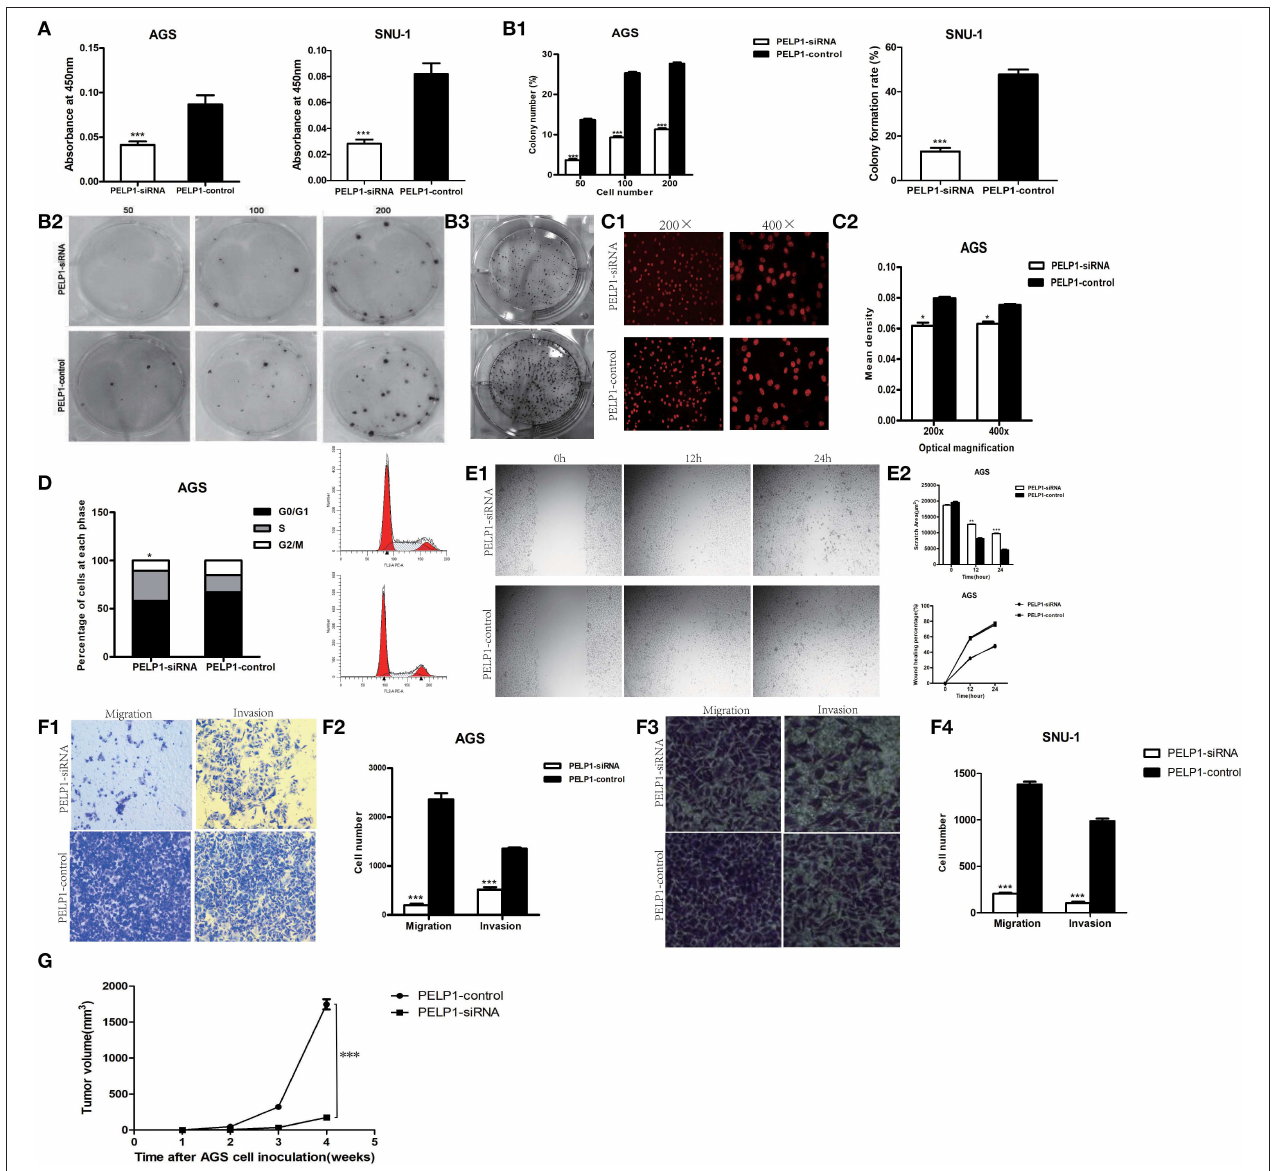
FIGURE 2 | PELP1 knowdown inhibited proliferation, migration and invasion, xenograft of gastric cancer cell. (A) The absorbance (OD) at 450nm wave-length was reduced in PELP1 knockdown group in CCK-8 assays. PELP1 silencing inhibited the colony formation ability of AGS (B1) and SNU-1 (B2) . (B3) Representative image for colony formation. (C1,C2) Representative image of the EdU assay confirmed that mean density was reduced in PELP1 knockdown group. (D) PELP1 knowdown prevented the cell progression from S phase into M phase in cell cycle arrest. The data represent results from one of three independent experiments. (E1,E2) Wound healing assay was used to detect the change of migration of cells. The migration ability of AGS was reduced in PELP1 knockdown group. Transwell small chamber assay was used to detect the change of migration and invasion of GC cells. (F1,F2) The migration and invasion ability of AGS was reduced in PELP1 knockdown group. (F3,F4) The migration and invasion ability of SNU-1 was reduced in PELP1-siRNA group. (G) PELP1 silencing inhibited the growth of xenograft in AGS cell inoculated nue mice. Experiments were repeated 3 or 4 times. Values are the mean ± SEM (* p < 0.05, ** p < 0.01, *** p <